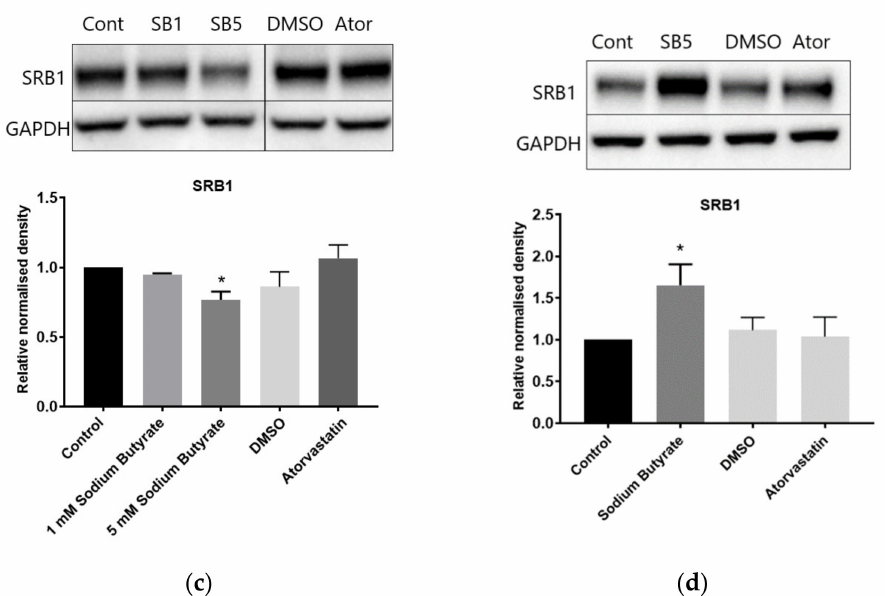
Figure 8. Influence of butyrate and atorvastatin on reverse cholesterol transport proteins in HepG2, BRIN-BD11 and THP-1 cells. Immunoblots of: ( a ) ABCA1 in HepG2 cells; ( b ) ABCA1 in BRIN-BD11 cells; ( c ) SBR1 in HepG2 cells; ( d ) SBR1 in THP-1 cells. Cells were treated with 1 mM (SB1) or 5 mM (SB5) sodium butyrate, or 10 µ M atorvastatin for 24 h in media containing LPDS. Control cells were treated with media only for butyrate and media containing DMSO for atorvastatin The graphs represent the mean density readings as normalised to GAPDH from three independent experiments, with error bars representing SEMs. * p < 0.05, ** p < 0.01, *** p < 0.001, **** p < 0.0001 compared to control. Table 1. Influence of butyrate and statins on ABCA1 protein levels in different cell types.